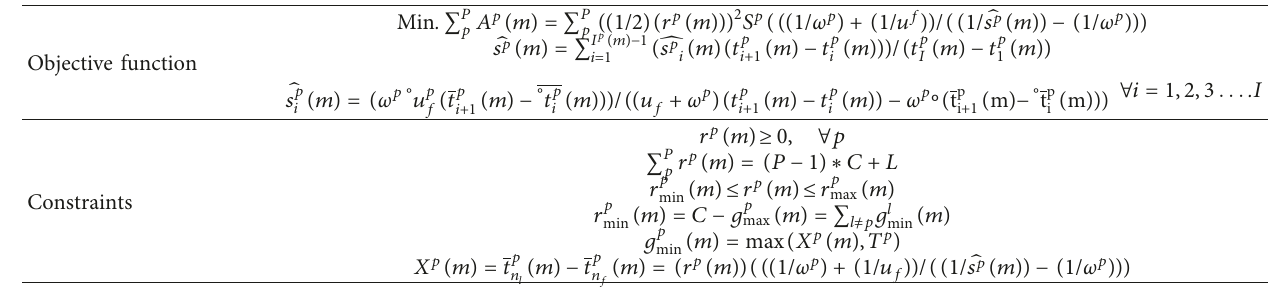
Table 2: Problem formulation of Model